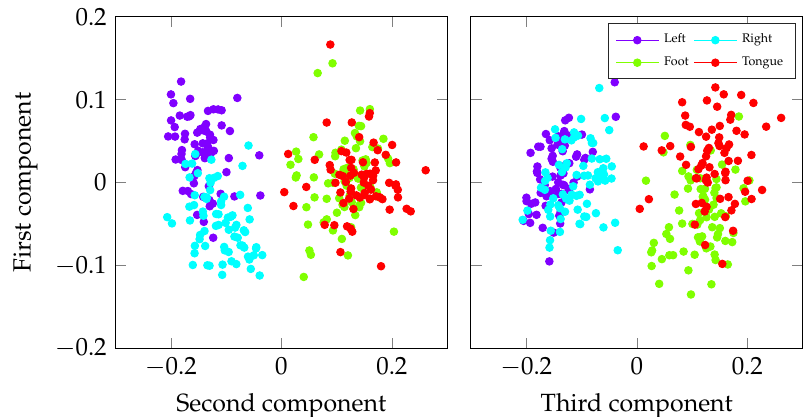
Figure 5. Resulting MKSSP kernel projected into three Kernel Principal Component Analysis (KPCA) components for the best performing subject (S07).